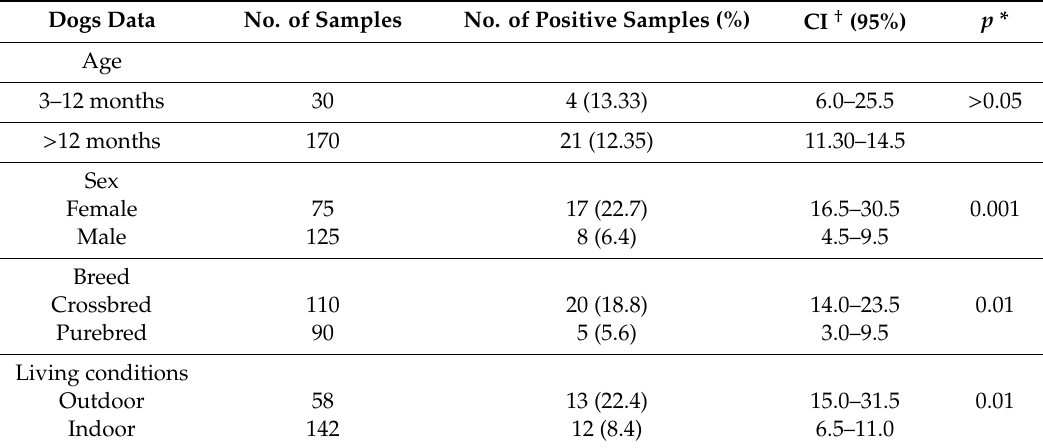
Table 1. Detailed sampling data of the dogs (age, sex, breed, and living conditions) and related positivity to P. multocida .